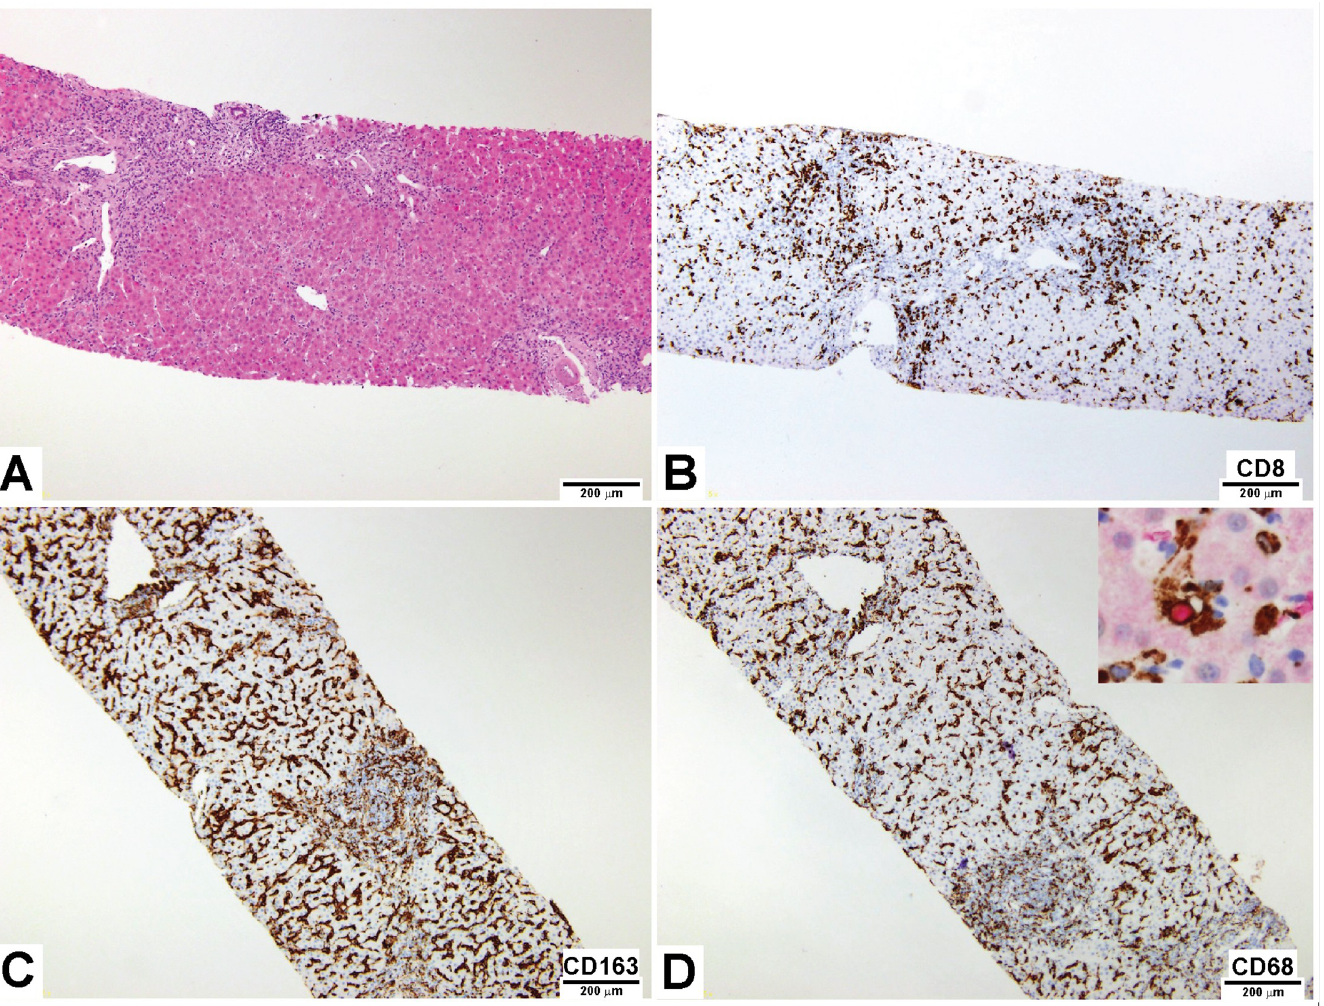
Peripheral blood mononuclear cells (PBMCs) from patients and controls were isolated by Ficoll centrifugation (LiStarFish). Total RNA was extracted from snap frozen percutaneous liver biopsy specimens and PBMCs using Trizol (Life technologies). cDNA was obtained using the Superscript Vilo kit (Invitrogen). Real-time PCR assays were performed using the TaqMan Universal PCR Master Mix (Applied Biosystems) and TaqMan gene-expression assays (Applied Biosystem). Gene expression data were normalized using HPRT1 (Applied Biosystem) as endogenous control. Data are expressed as arbitrary units (AU), determined using the 2 - Δ ct